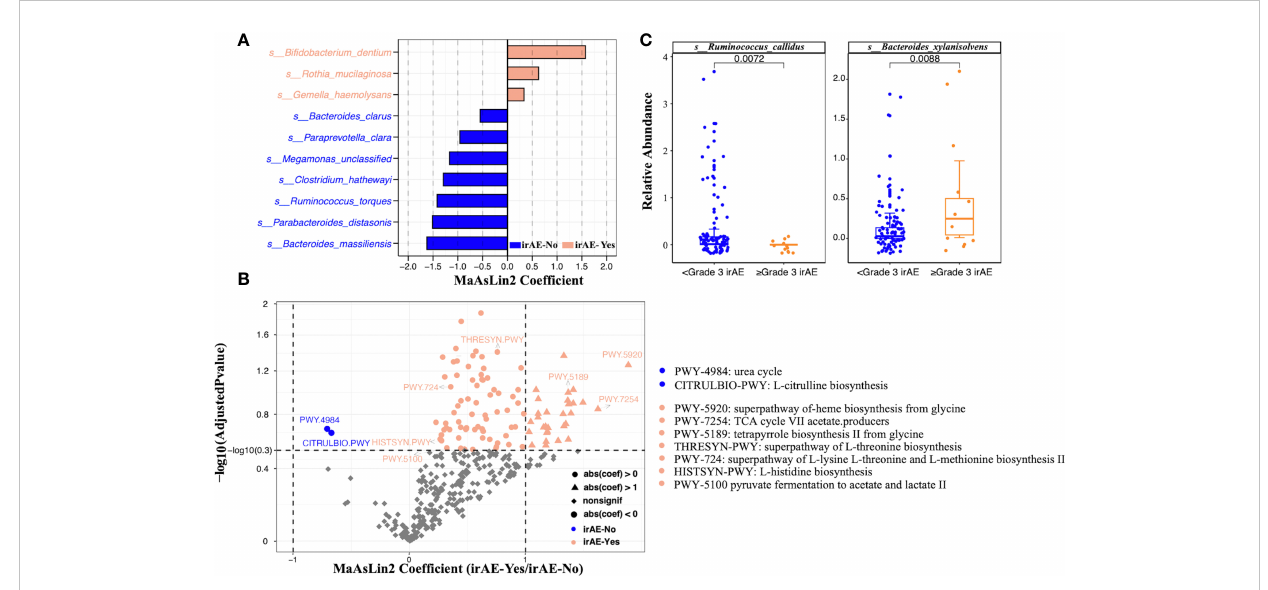
FIGURE 3 Signi fi cantly differential species and metabolic pathways between irAE and non-irAE groups. The analysis was performed on all patients. (A) Butter fl y plot of differential bacterial species between patients with and without irAEs. The x axis shows the effect size represented by MaAsLin2 coef fi cient (positive number means enrichment in the irAE group; negative number means enrichment in the non-irAE group). (B) Volcano plot of microbial metabolic pathways. The x axis shows the effect size represented by MaAsLin2 coef fi cient (positive number means enrichment in the irAE group; negative number means enrichment in the non-irAE group). The dashed horizontal line shows adjusted P value of 0.3 and the two dashed vertical line showed coef fi cients of -1 and 1. (C) Boxplots showing the relative abundance of Ruminococcus callidus and Bacteroides xylanisolvens in the mild (<grade3) and severe ( ≥ grade3) irAE groups. Wilcoxon rank sum test was applied, and p values were labeled for each comparison.